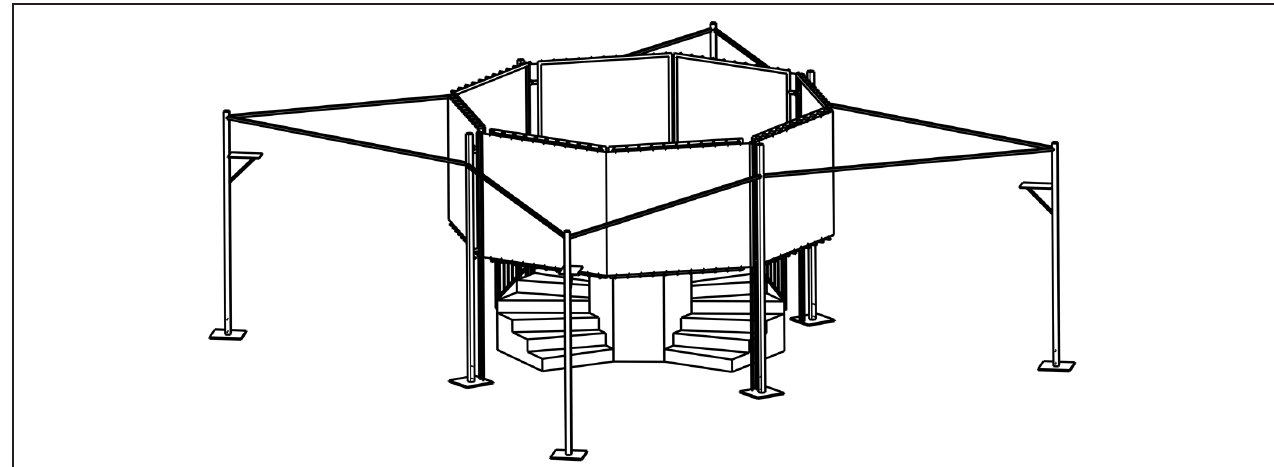
FIGURE 1 | Experimental installation “Kaleidoscope of Time.” The participant enters the installation through a small staircase and stands on a tower, where eight video screens are visible that show video recordings/representations of him/her. Beamers projecting the video signals on back projection screens were positioned on the four columns in the periphery of the